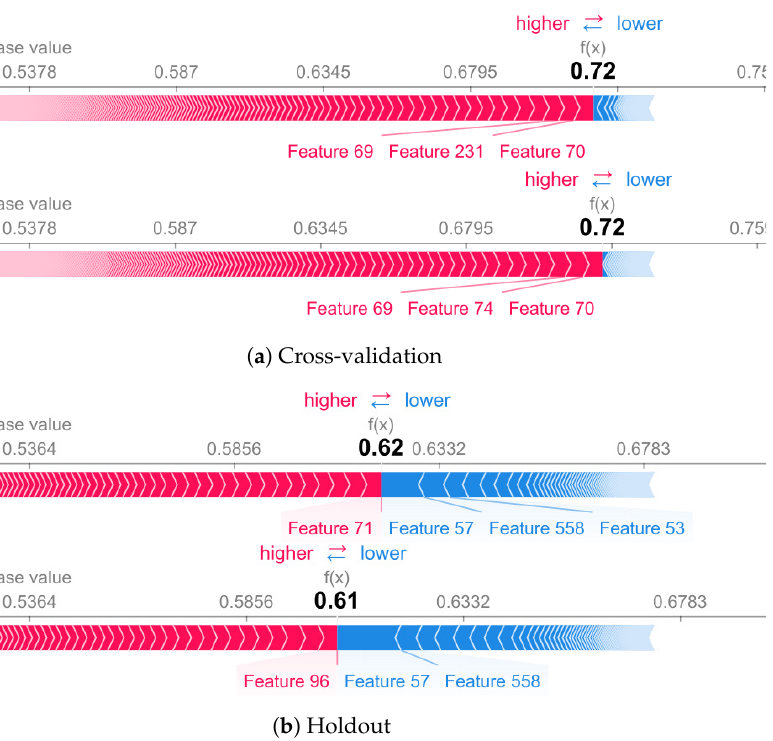
Figure 10. Walking upstairs activity for cross-validation ( a ) and holdout ( b ) validation